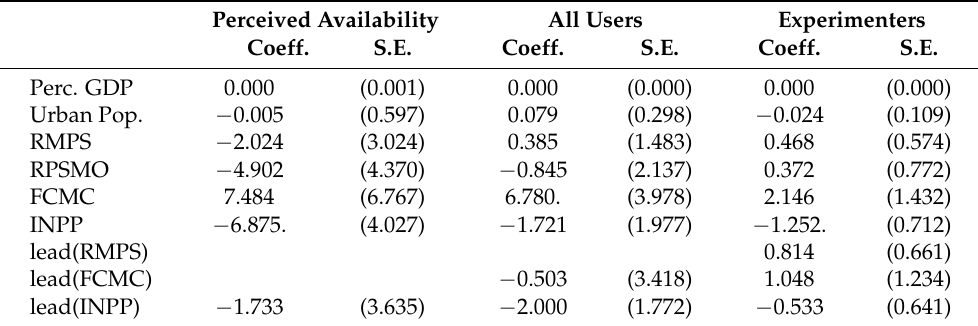
Table 7. Parallel trend test of estimated association between cannabis policy reforms and changes in perceived availability of cannabis by all students, past-year prevalence of all cannabis users and experimental